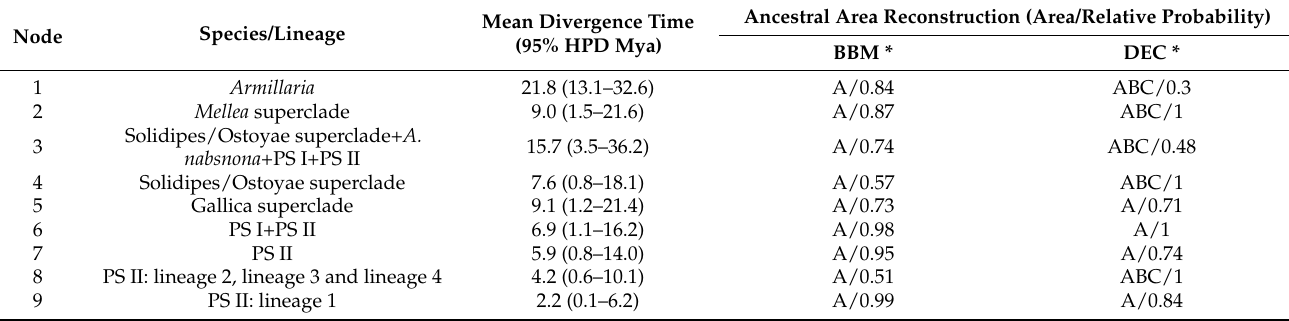
Figure 4. Chronogram of Armillaria from the northern hemisphere. The time-scale is set to the mean divergence dates produced in BEAST. The most recent common ancestor (tMRCA) of Armillaria and Desarmillaria (node 1) was estimated based on Dataset IV and its chronogram is shown in Figure S3. Numbered nodes refer to mean divergence dates, with their 95% HPD and ancestral state provided in Table 3. The pie chart in each node indicates the possible ancestral distributions inferred from Bayesian Binary MCMC analysis (BBM) implemented in RASP. Red branches identify dispersal events inferred by RASP based on the Dispersal-Extinction-Cladogenesis (DEC) model. Table 3. Divergence time estimates of BEAST analyses for internal nodes of northern hemisphere Armillaria , with results of ancestral range estimation using the BBM and DEC models.